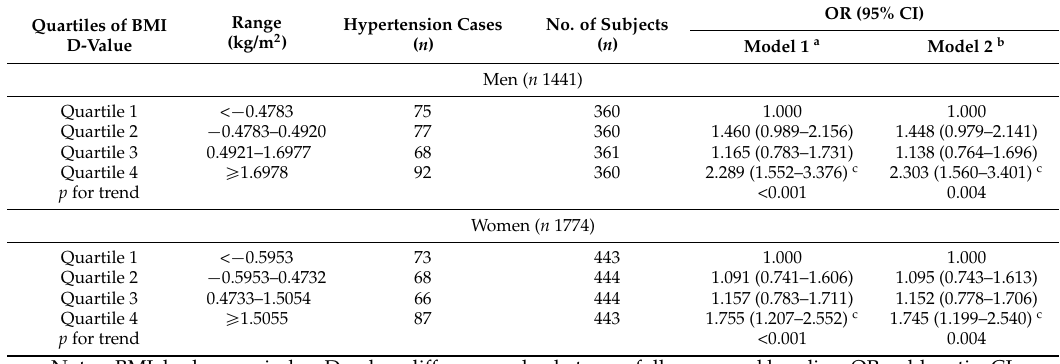
Table 2. The incidence of hypertension associated with BMI D-value in men and